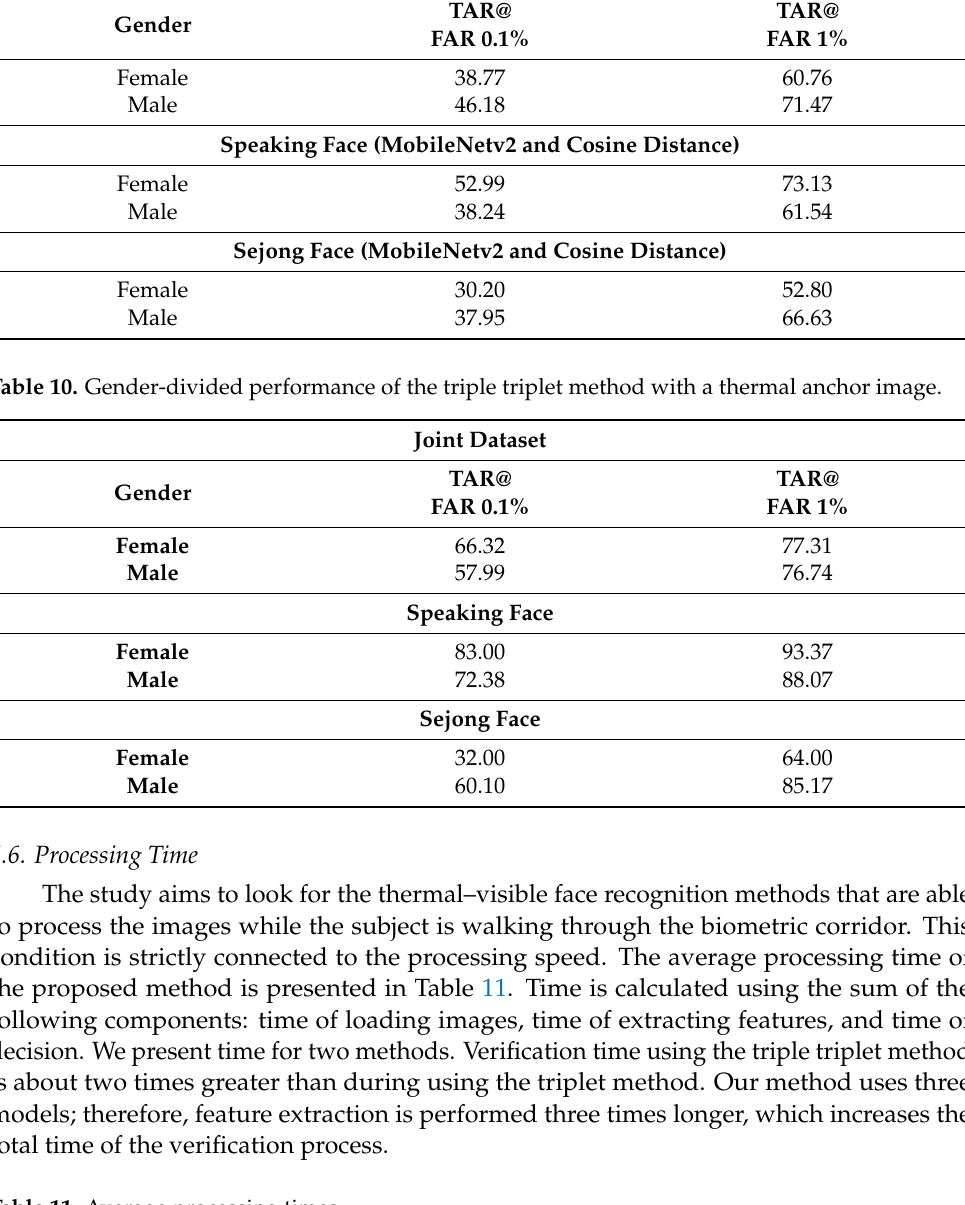
Table 11. Average processing